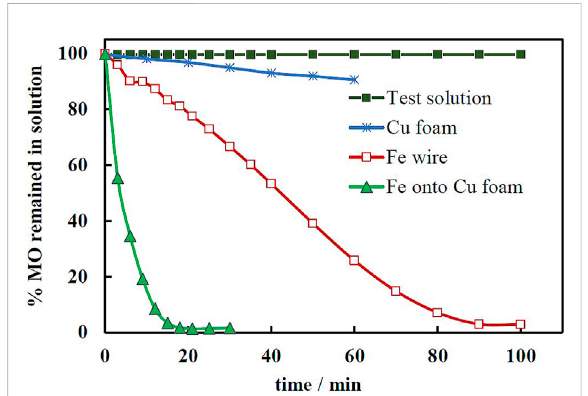
FIGURE 1 Preliminaryevaluationofthecatalytic activityofplane and3D surface catalysts for degradation of MO. The geometrical area was 1 cm 2 on all used substrates. The catalysts were electrodeposited at-1.5 Vandq=150 C.Thetestsolutioncontained100 mg/L of MO, 20 g/L Na 2 SO 4 and 25 µL of H 2 O 2